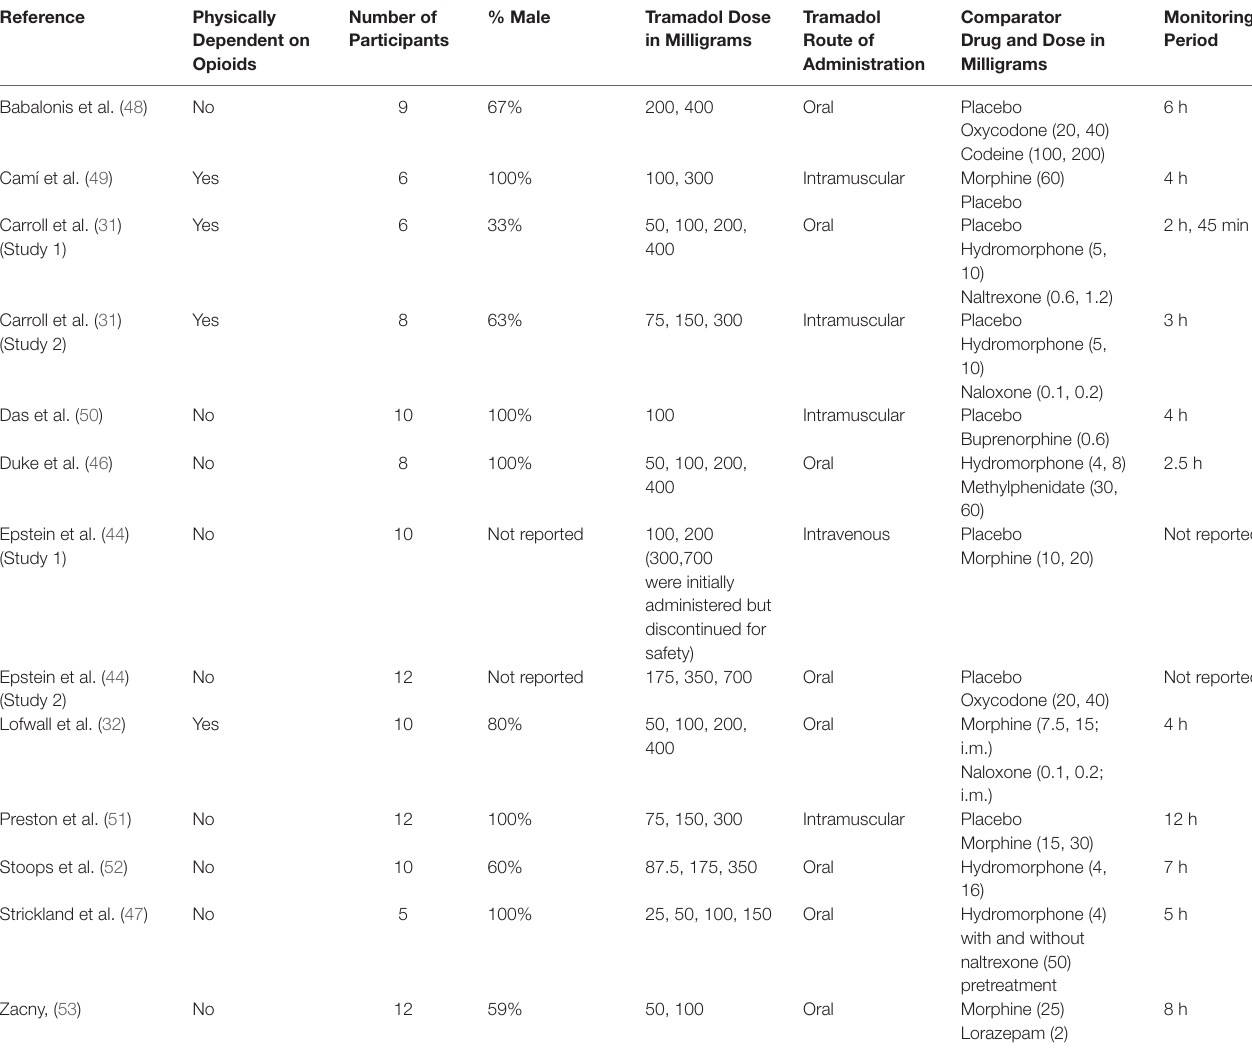
TABLE 1 | Summary of Reviewed